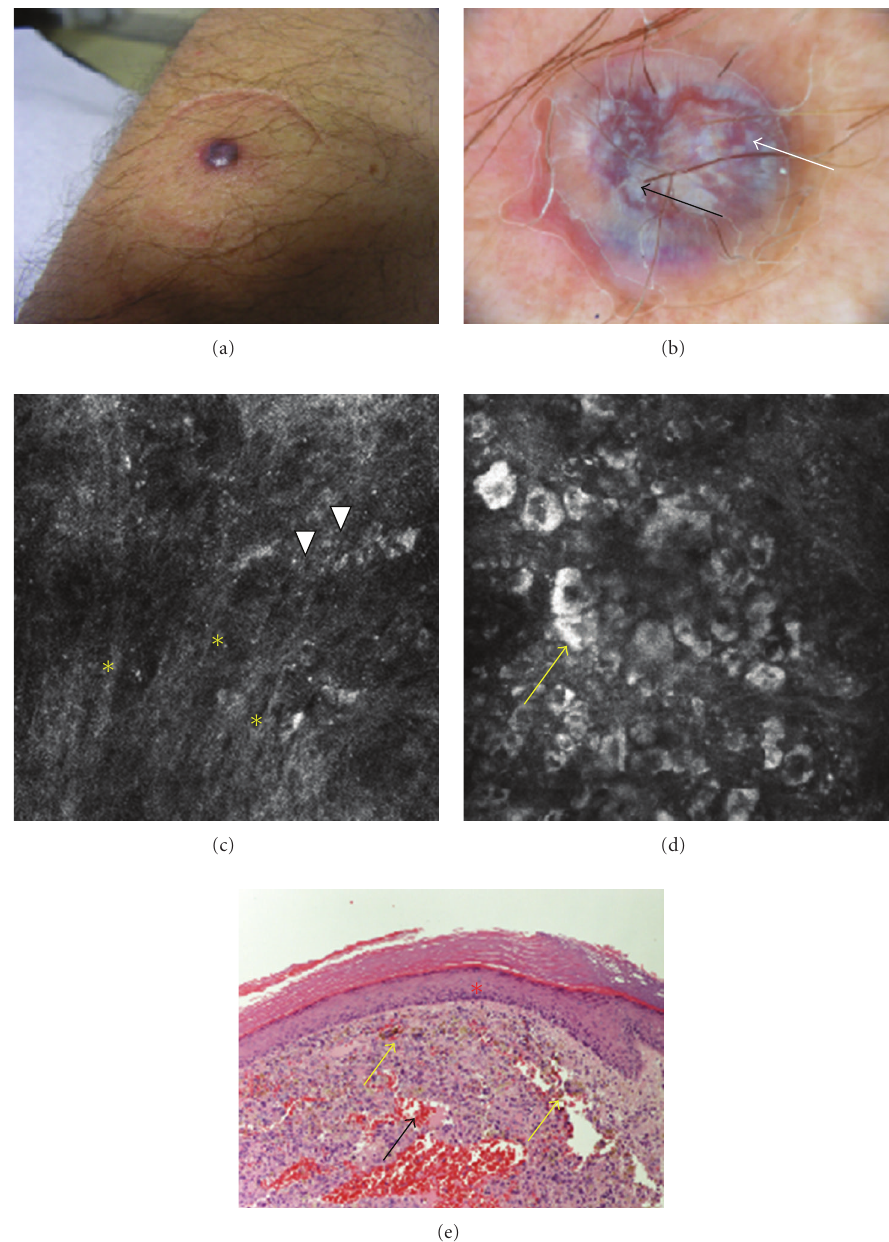
Figure 1: Forearm of a 54-year-old man. A hard blue asymptomatic nodule (a). Dermoscopically, the lesion showed a purple-bluish hue (white arrow), with a whitish veil and chrysalis structures (black arrow) ((b) 30x magnification). The confocal images show thick hyporeflective fibers of collagen in the dermis (yellow asterisks). Among these, hyperreflective dotted particles (white arrow heads) and several large multinucleated cells, plump and refractile, were seen (yellow arrow) ((c), (d) details 500 × 500 µ m). Histology revealed a fibrous hystiocytoma, with spindled fibro-hystiocytes, blood extravasation (black arrow) and numerous siderophages ((e) HH 20x magnification): in particular, plump bright multinucleated cells were identified as haemosiderophages, clearly visible in the upper portion of the dermis (yellow arrow). The flattening of the dermal-epidermal junction is highlighted by a red